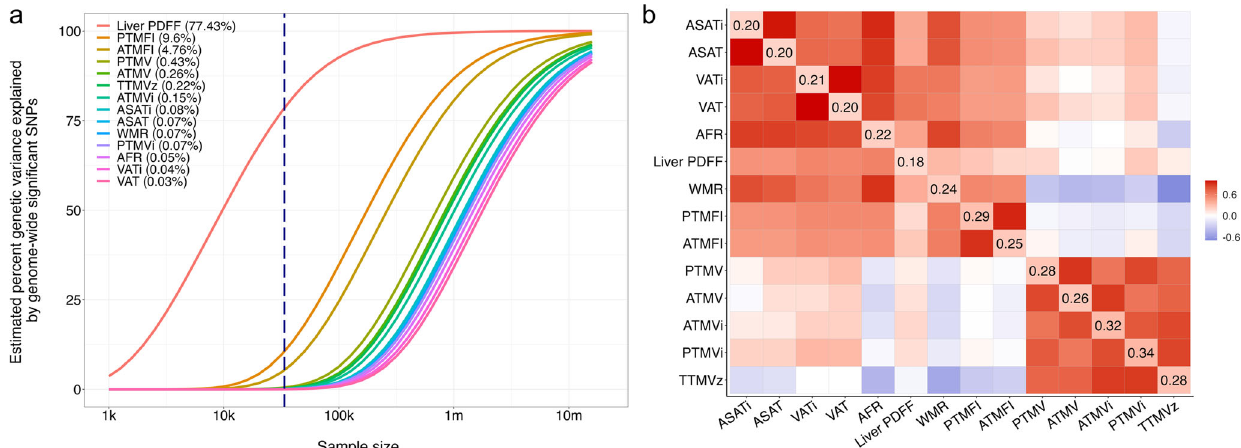
Fig. 1 Comparison of the genetic architecture of individual body composition measures. a The relation between genetic variance explained by genome- wide signi fi cant hits ( y -axis) and sample size ( x -axis) for each measure (solid-colored lines). The vertical dashed blue line marks the current sample size, with the corresponding percent genetic variance explained indicated between brackets in the legend. b Correlation between the measures, with phenotypic correlation shown in lower-left section and genetic correlation in the upper-right section, and heritability on the diagonal. Abbreviations: ASAT abdominal subcutaneous adipose tissue, VAT visceral adipose tissue, AFR abdominal fat ratio, WMR weight-muscle-ratio, ATMV anterior thigh muscle volume, PTMV posterior thigh muscle volume, ATMFI anterior thigh muscle fat in fi ltration, PTMFI posterior thigh muscle fat in fi ltration, Liver PDFF liver proton density fat fraction, TTMVz total thigh muscle volume z -score, i index, referring to a measure divided by standing height 2